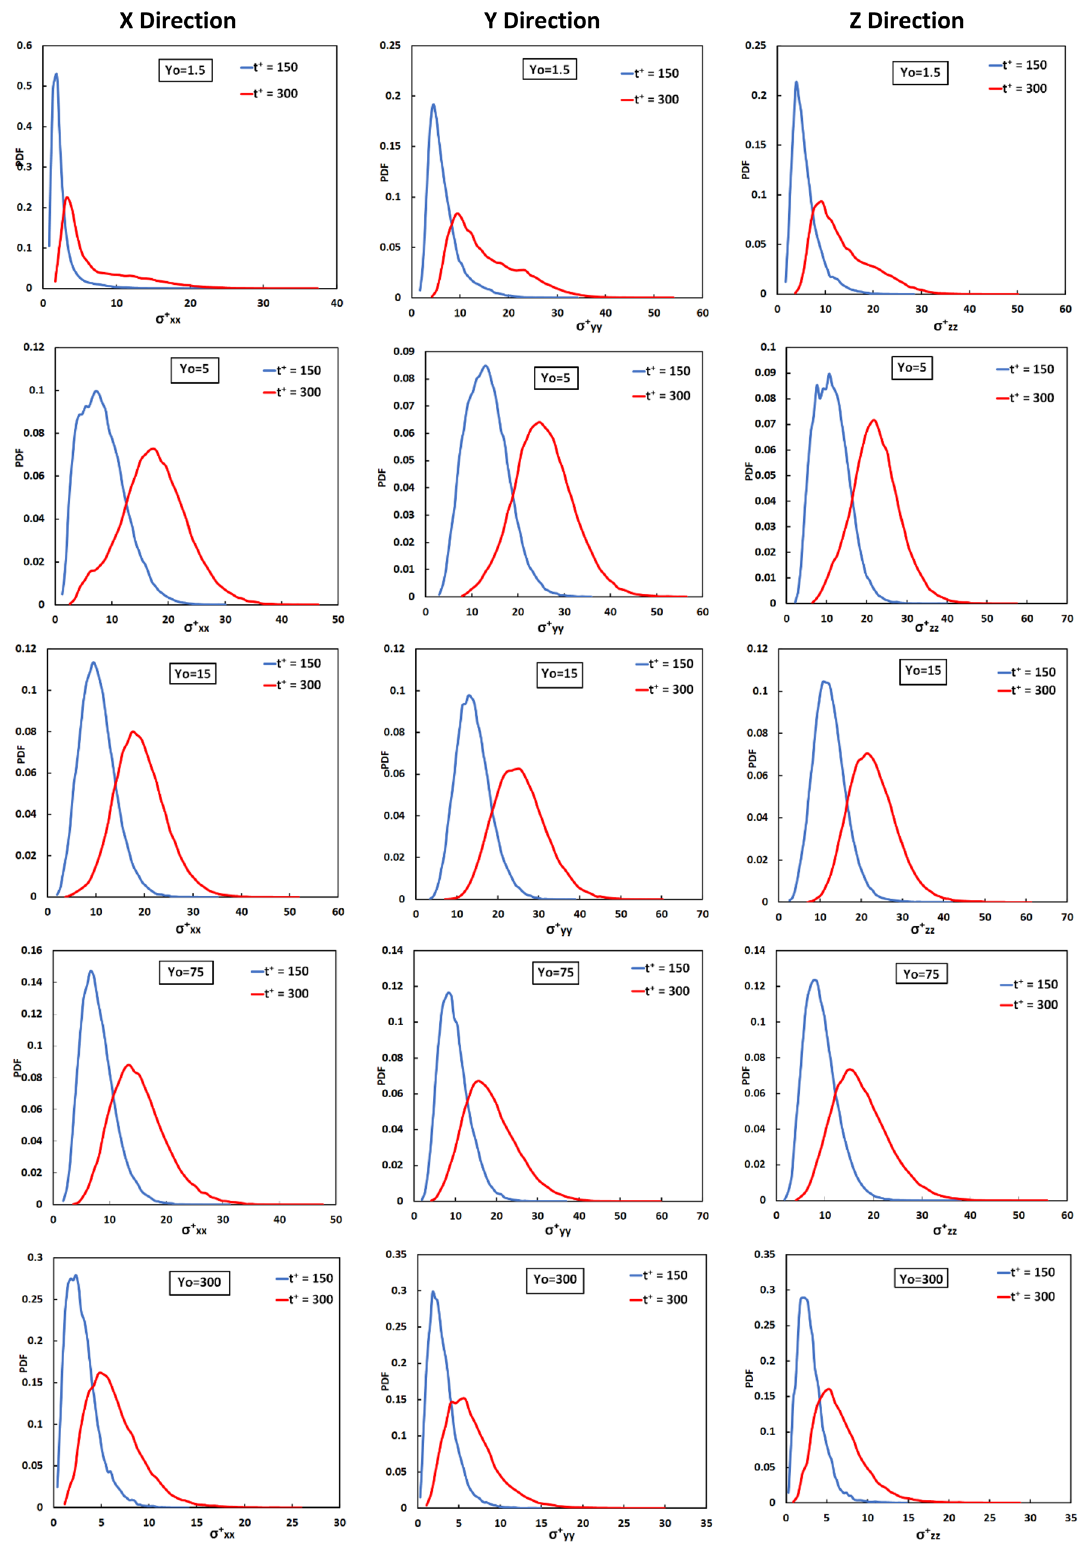
Figure 8. Probability density function of the extensional stress histories in x , y , z , directions for particles released at different positions at t + = 150 and 300 in the Poiseuille flow